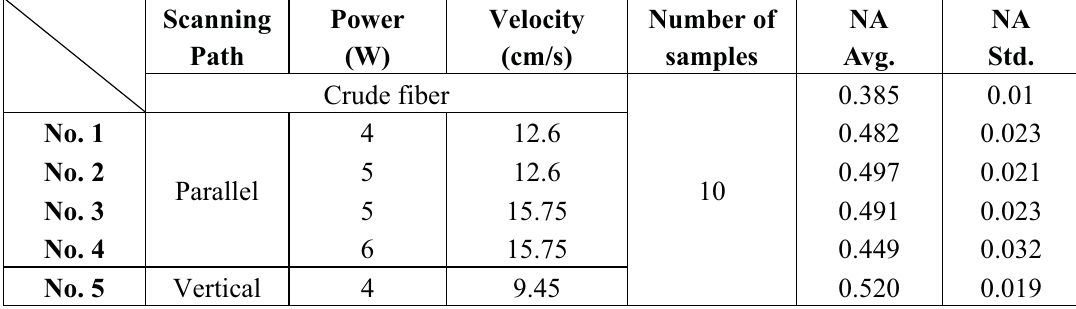
Table 4. Results of numerical aperture measurements.